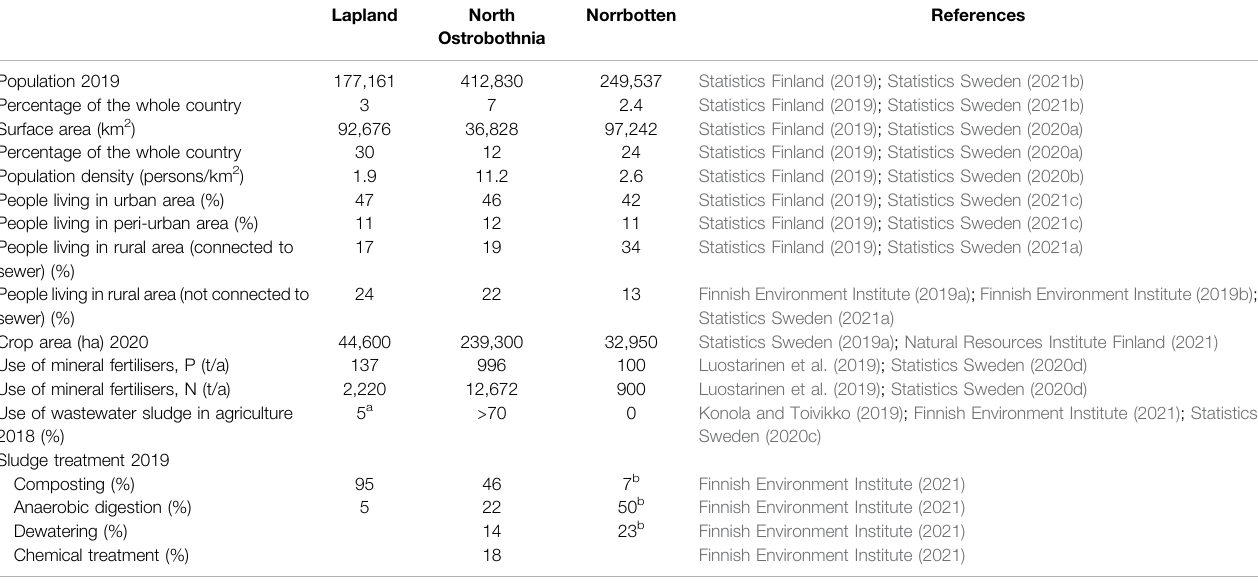
TABLE 1 | Statistics for the study area including Lapland and North Ostrobothnia in Finland and Norrbotten in Sweden.